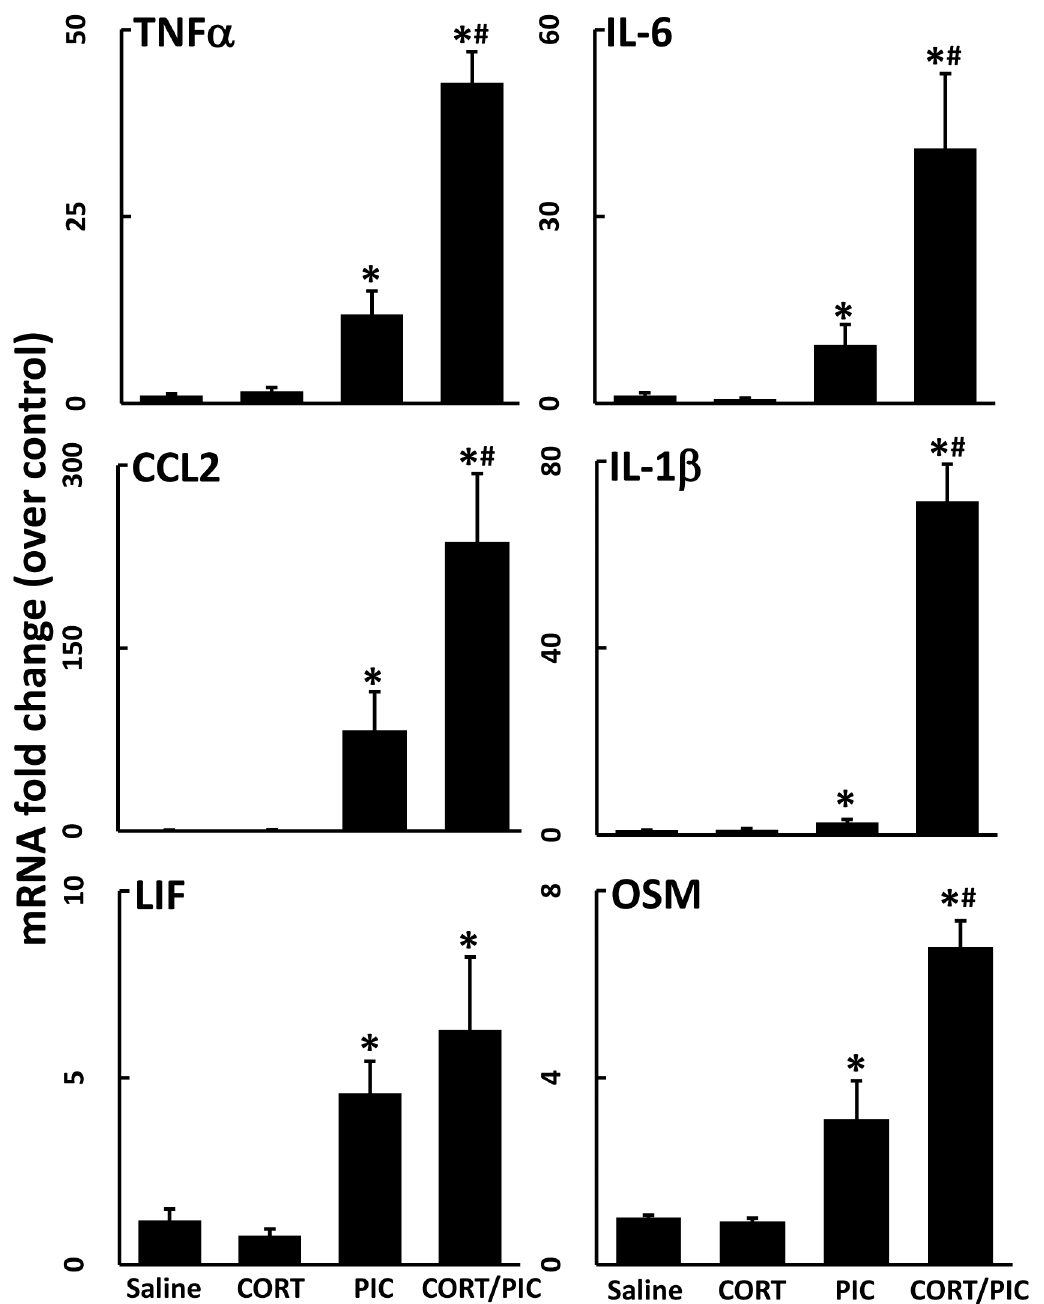
Fig 5. Chronic CORT exacerbates PIC-induced neuroinflammation. Mice were pretreated with CORT (200 mg/L 0.6% EtOH in drinking water for one week). TNF α , IL-1 β , LIF, and OSM mRNA levels were measured in samples prepared from cortex collected 6 hours after PIC exposure (12 mg/kg, i.p.). Data represent mean ± SEM (n = 5 mice/group). Statistical significance of at least P < 0.05 is denoted by (cid:3) as compared to respective control group.